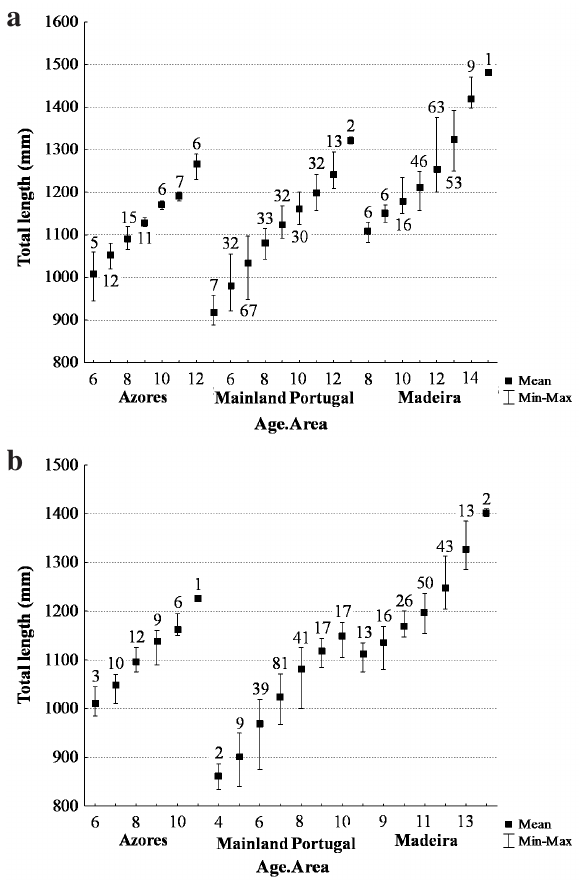
Fig . 9. – distributions of length-at-age for Aphanopus carbo caught off Azores, mainland Portugal and Madeira; (a) females; (b) males. numbers plotted with symbols are the sample size at age.